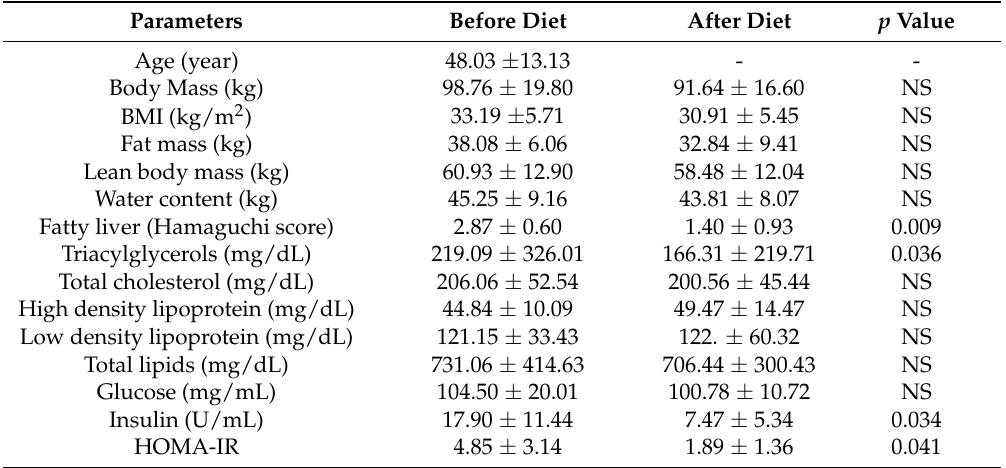
Table 2. Baseline characteristics of the study cohort ( n = 32), as well as effects of the dietetic intervention.